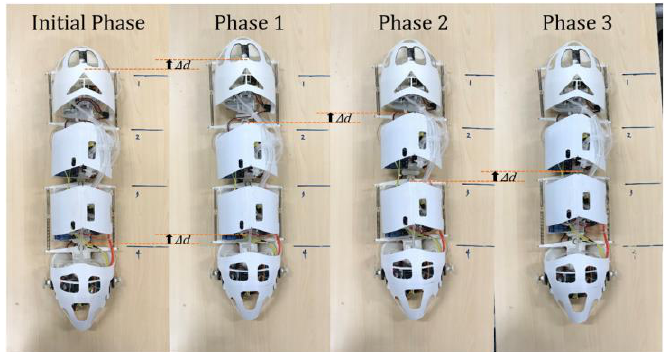
Figure 5. Four motion phases in a single cycle of the straight crawling process.